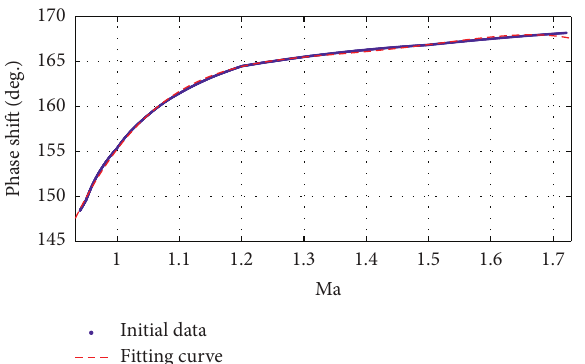
Figure 6: Polynomial fitting for phase shift.